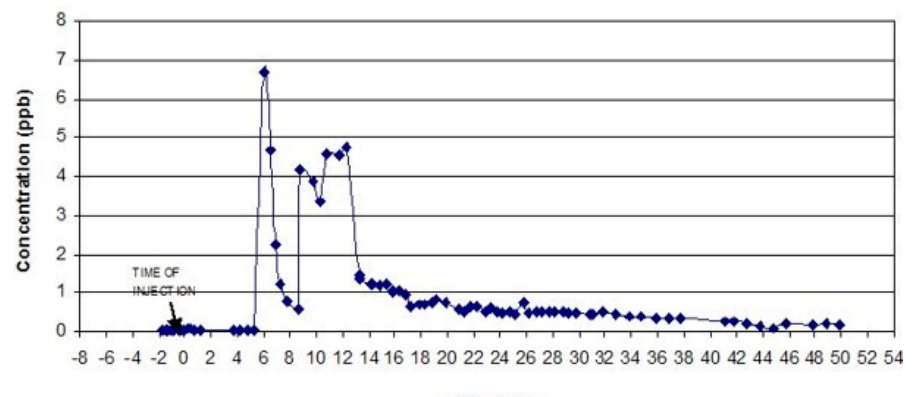
Figure 7. Diagram of eosine concentrations at the Seyed Hossein spring.